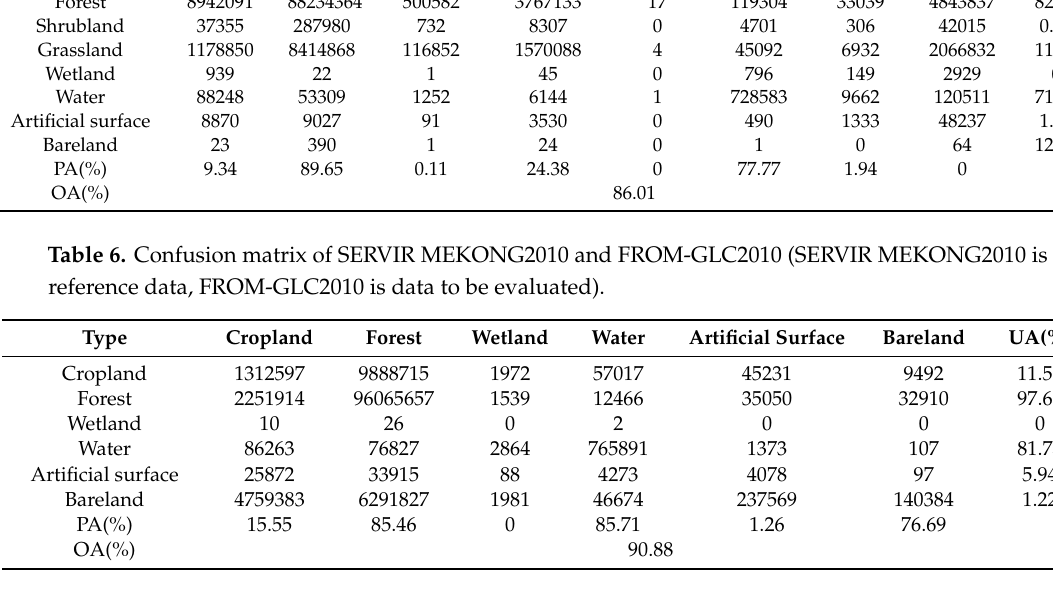
Table 7. Confusion matrix of Globeland30-2010 and SERVIR MEKONG2010 (Globeland30-2010 is reference data, SERVIR MEKONG2010 is data to be